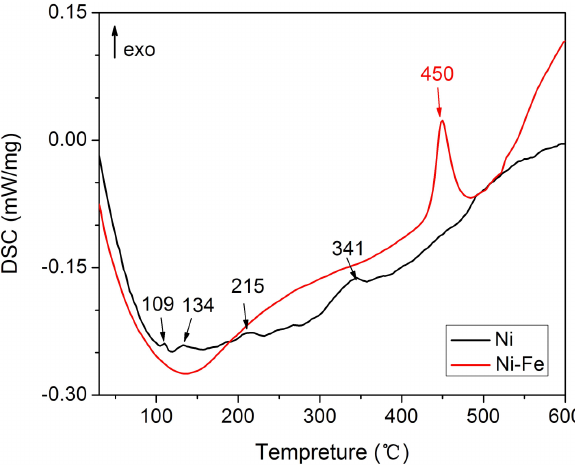
Figure 2: Typical DSC curves of NC Ni and Ni-Fe samples at a heating rate of 20K · min −1